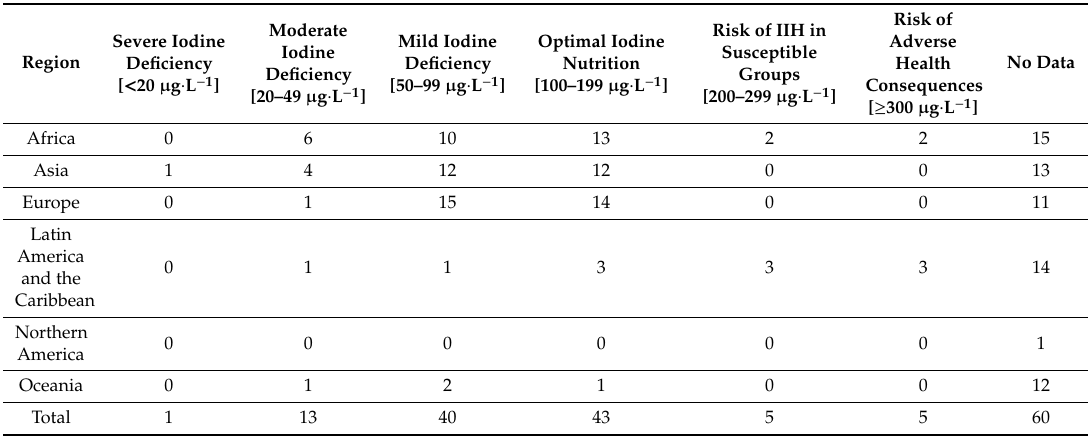
Table 1. Country data on median urinary iodine concentrations and urinary iodine concentrations in school-age children by region